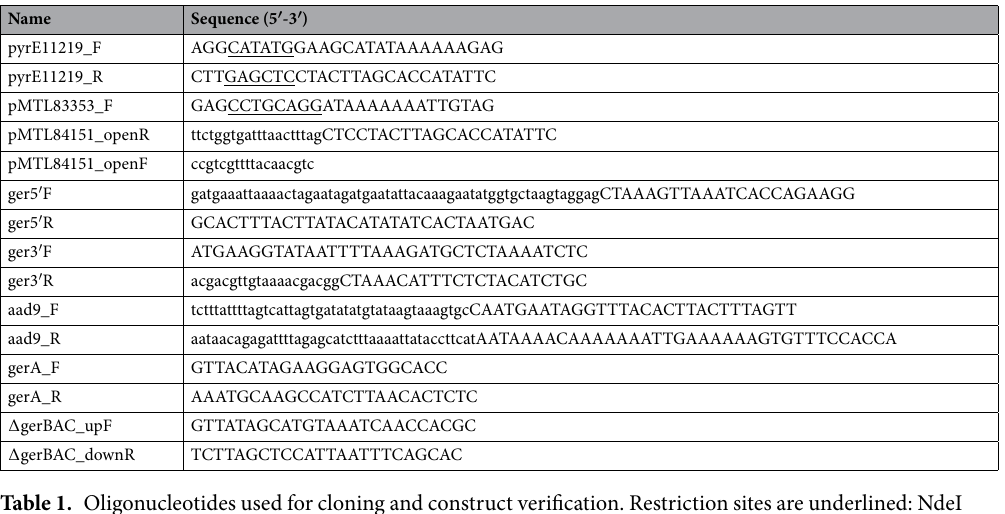
Table 1. Oligonucleotides used for cloning and construct verification. Restriction sites are underlined: NdeI (CATATG), SacI (GAGCTC) and SbfI (CCTGCAGG). The small letters indicate the overhang region of the primer, necessary for annealing fragments via Gibson